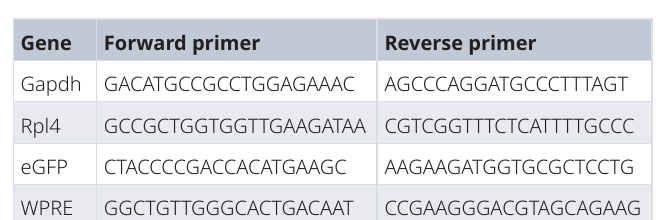
Table 1. Primers